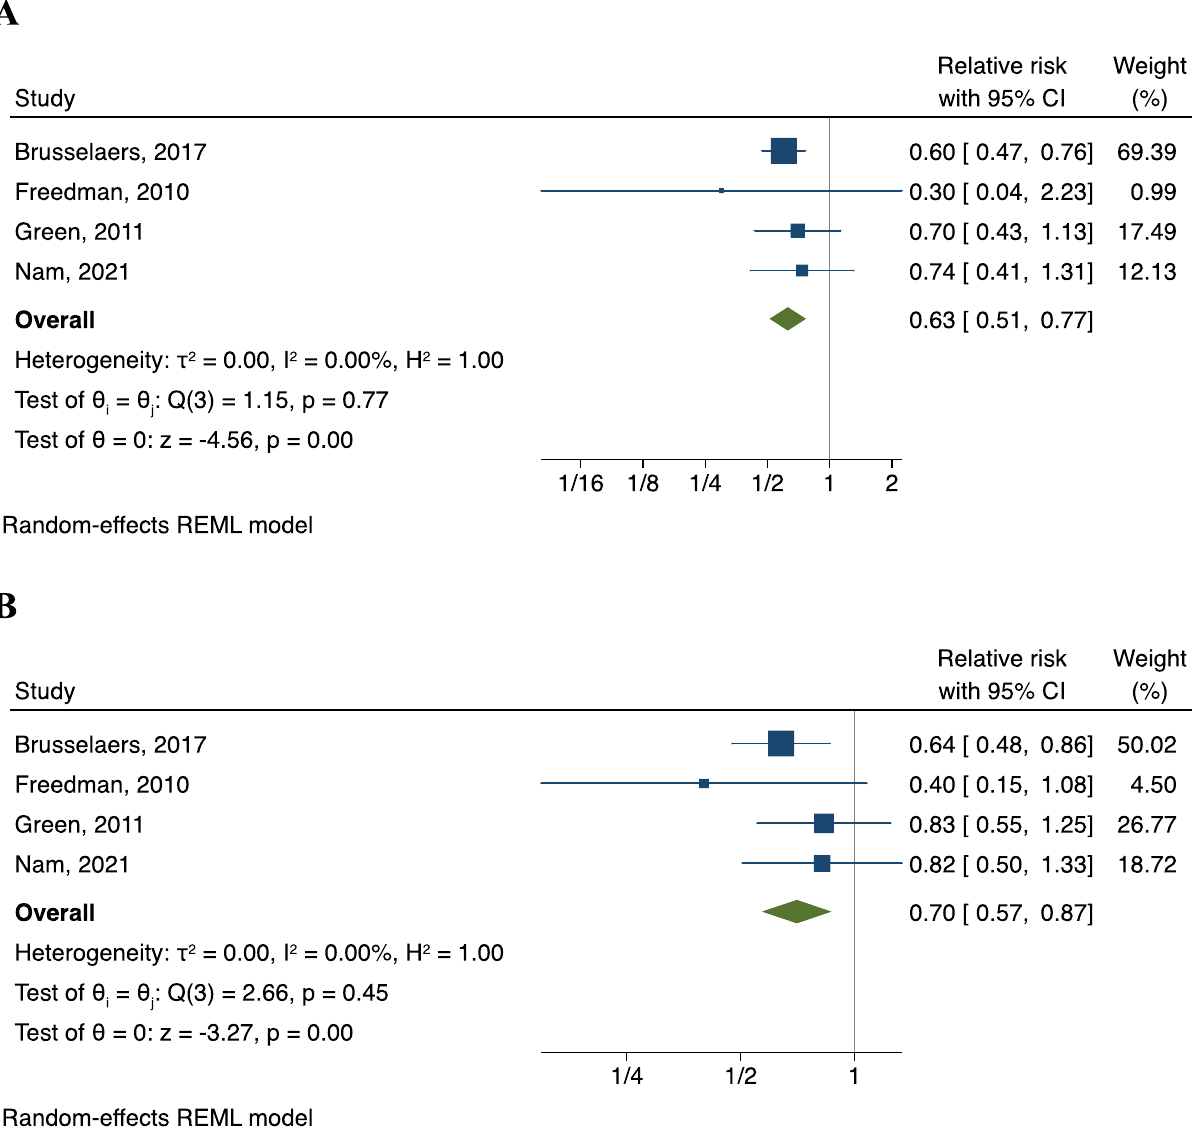
Figure 3. Subgroup analyses. The association of the use of ( A ) estrogen-only HRT and ( B ) combined estrogen- progestin therapy with gastric cancer risk. RR relative risk, CI confidence intervals, HRT hormone replacement